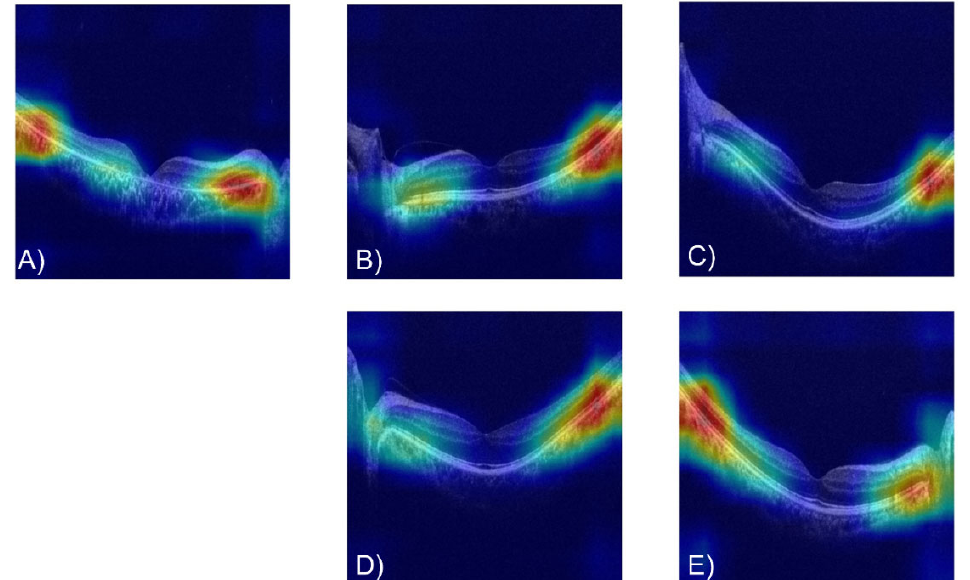
Figure 5. Representative visual explanations of the feature map of the CNN model in the misrecog- nized OCT images. The heat maps in ( A – E ) indicate the relative activation intensity of predicting abnormalities in OCT images. The CNN model made a decision based on the location of the warm color. The CNN model classified ( A ) an abnormal eye (retinitis pigmentosa) as normal and ( B – E ) a normal eye as abnormal.